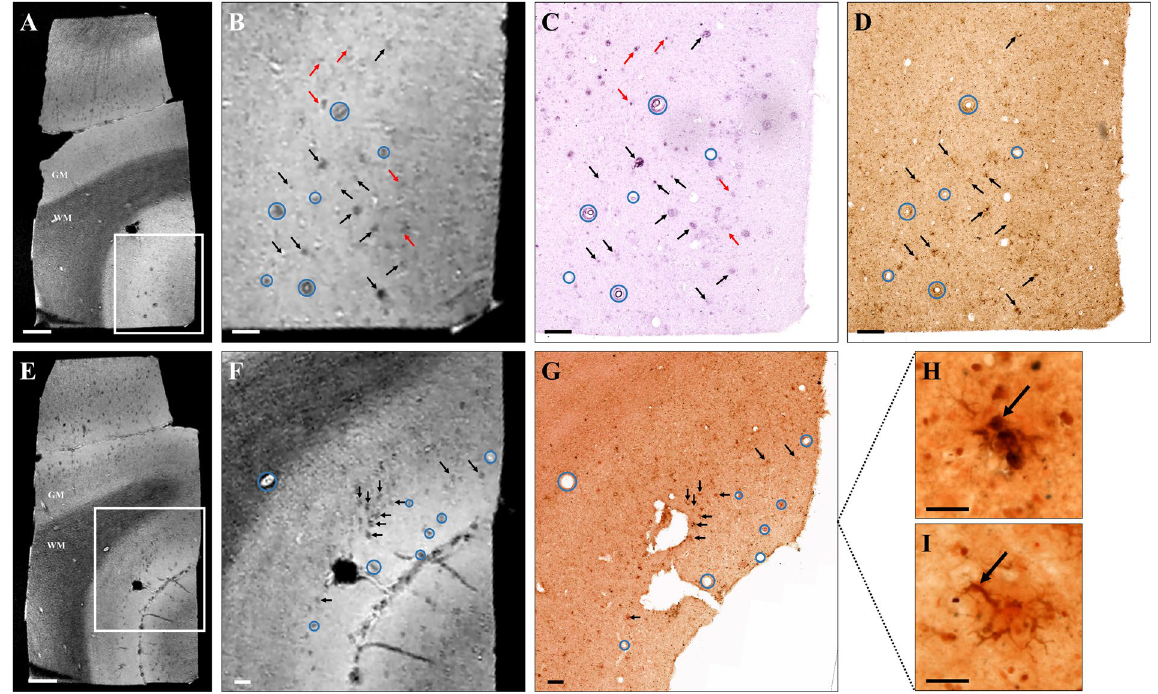
Figure 8. Amyloid plaque detection by Gd-stained MRI in human Alzheimer’s disease brains. Gd-stained post mortem MR images ( A , B , E , F ) were registered with histological sections stained for β -amyloid (BAM10, C ), iron (Perls-DAB, D ) or double-stained for β -amyloid and iron (Congo red/Perls-DAB, G ). Grey and white matter (GM and WM respectively) could easily be identified in Gd-stained MRI ( A , B , E , F ). Numerous hypointense spots were visible in the grey matter of AD patients ( A , B , E , F ). Slices were registered according to orientation and landmarks such as blood vessels (blue circles). Most of the hypointense spots (black and red arrows) seen on MR images ( A , B , E , F ) can be registered with β -amyloid lesions (black and red arrows) on BAM10 ( C ) and Congo-red/Perls-DAB ( G ) stained histological sections. Iron staining (Perls-DAB) revealed iron deposits that co-localize with amyloid plaques ( D , G , black arrows) in most of the human plaques. Some other plaques were iron-free ( C , D , red arrows) and were also detected by MRI indicating that iron is not necessary for detection. Perls-DAB-stained sections demonstrate two types of iron accumulation near amyloid plaques ( H , I ): punctate ( H ) or intracellular deposits ( I ). Scale bars: 1000 µ m ( A , E ), 200 µ m ( B–D , F , G ) and 50 µ m ( H , I